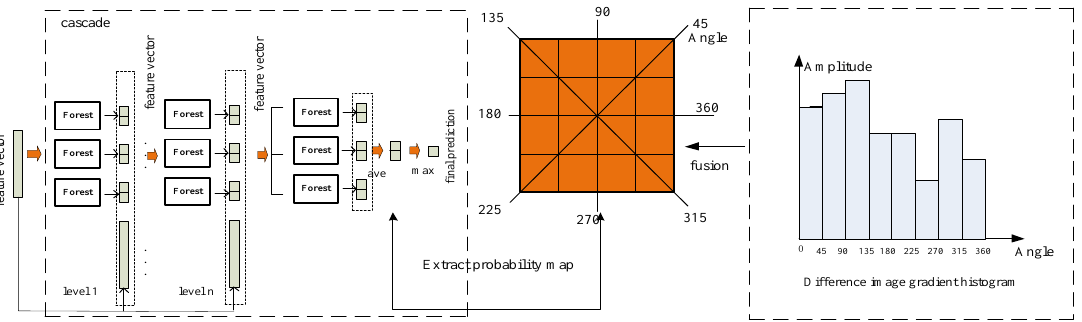
Figure 7. The probability map combined with the gradient histogram of the difference